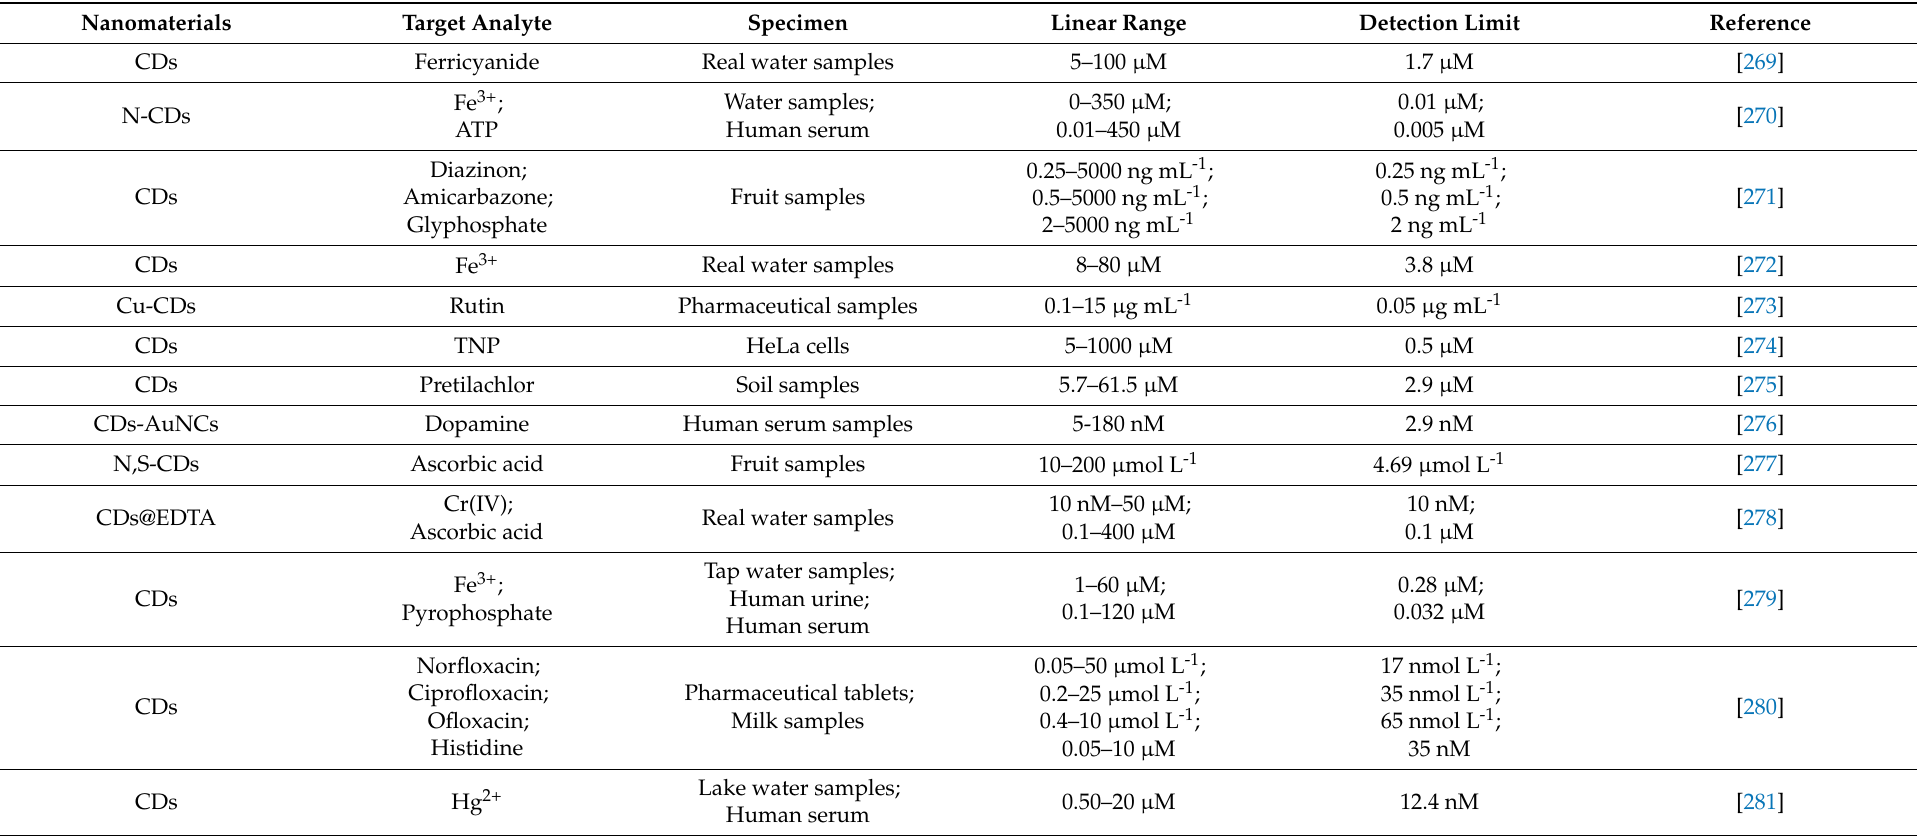
Table 2. CDs-based fluorescence biosensors reported (2018 onwards) for healthcare